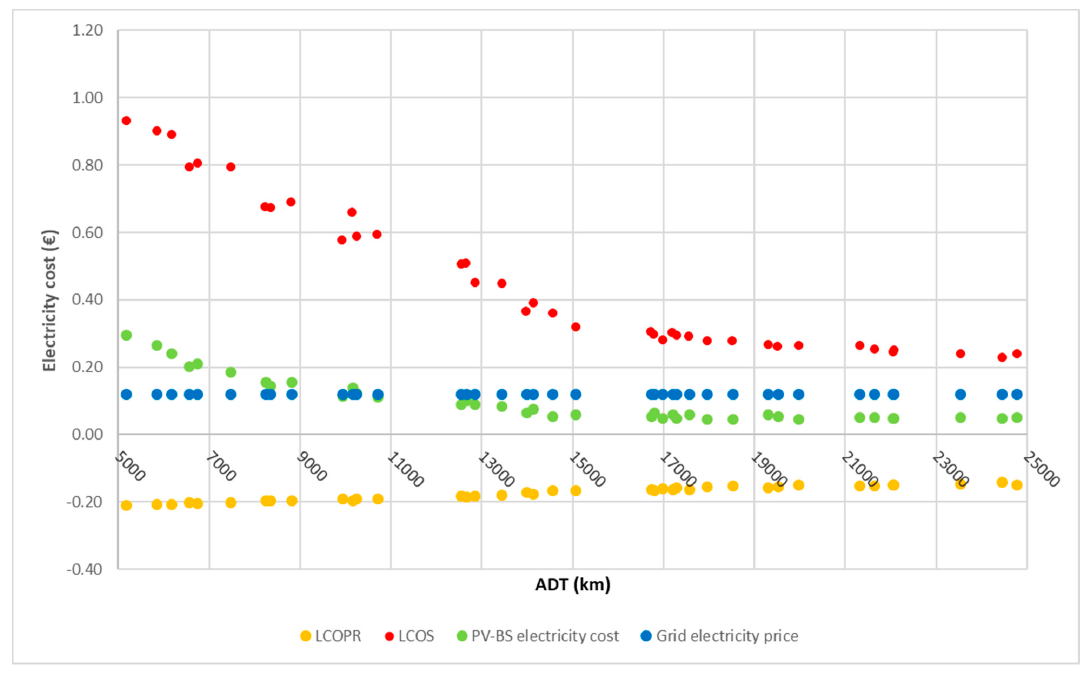
Figure 4. LCOPR, LCOS, and PV–BS electricity cost in the base-case scenario with solar forecast-based strategy.